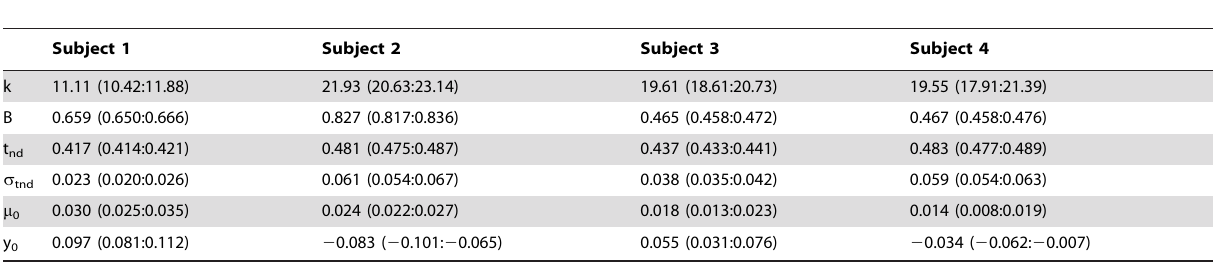
Table 1. Fitted parameters of the accumulation-to-bound model to the initial